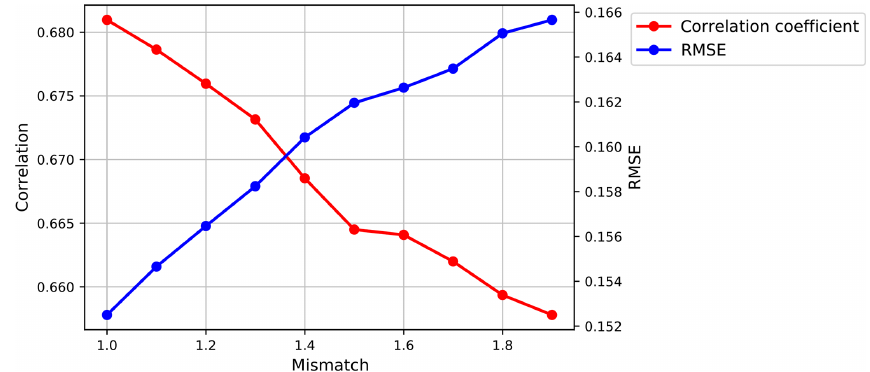
Figure 10. Correlation (in red) and RMSE (in blue) variations as a function of the mismatch between the satellite observation and the simulated signal (test 3). The figure refers to the CISAR AOT retrieval evaluation against AERONET data. These results are obtained from CISAR applied to SEVIRI observations.